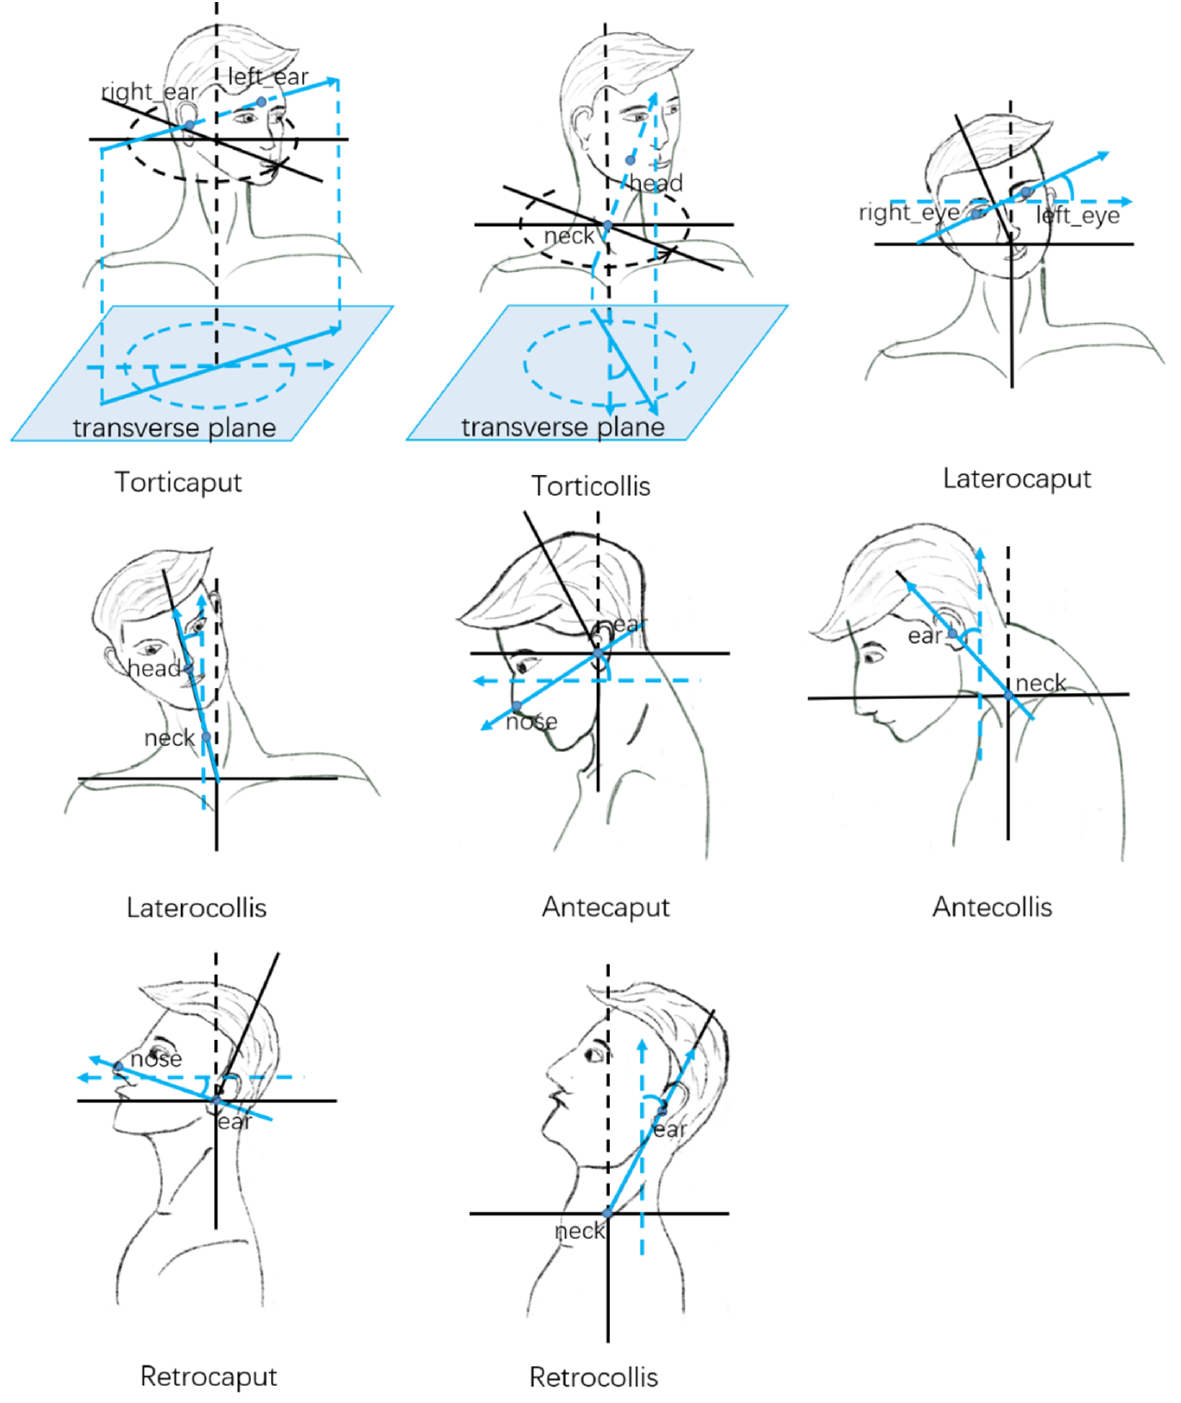
Figure 5. The human keypoints of the subject.